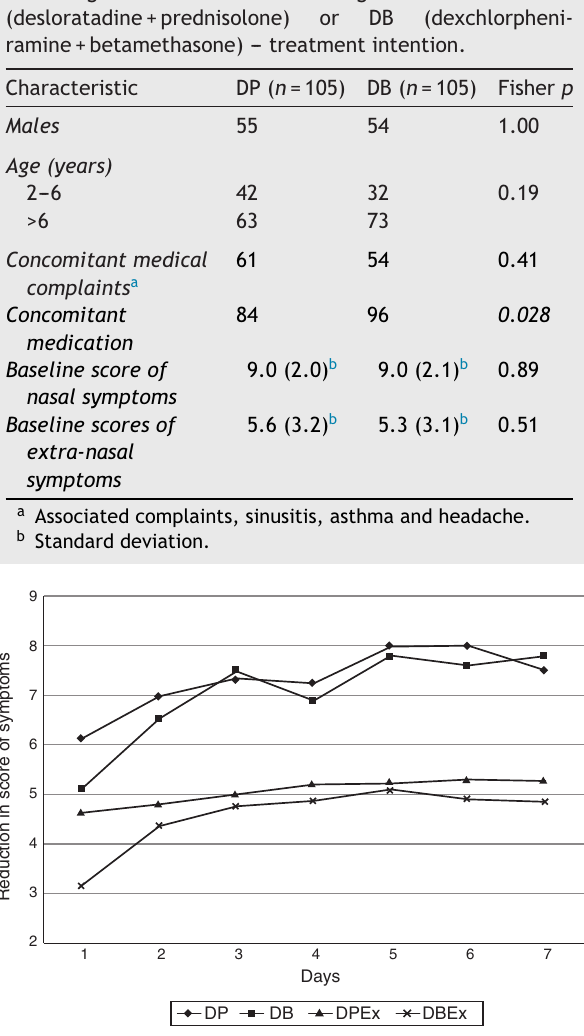
Progression of score (average) of nasal and extranasal (Ex) symptoms according to the treatment group: desloratadine + prednisolone (DP and DPEx, respectively) or dexchlorpheniramine + betamethasone (DB and DBEx, respec- tively) according to different